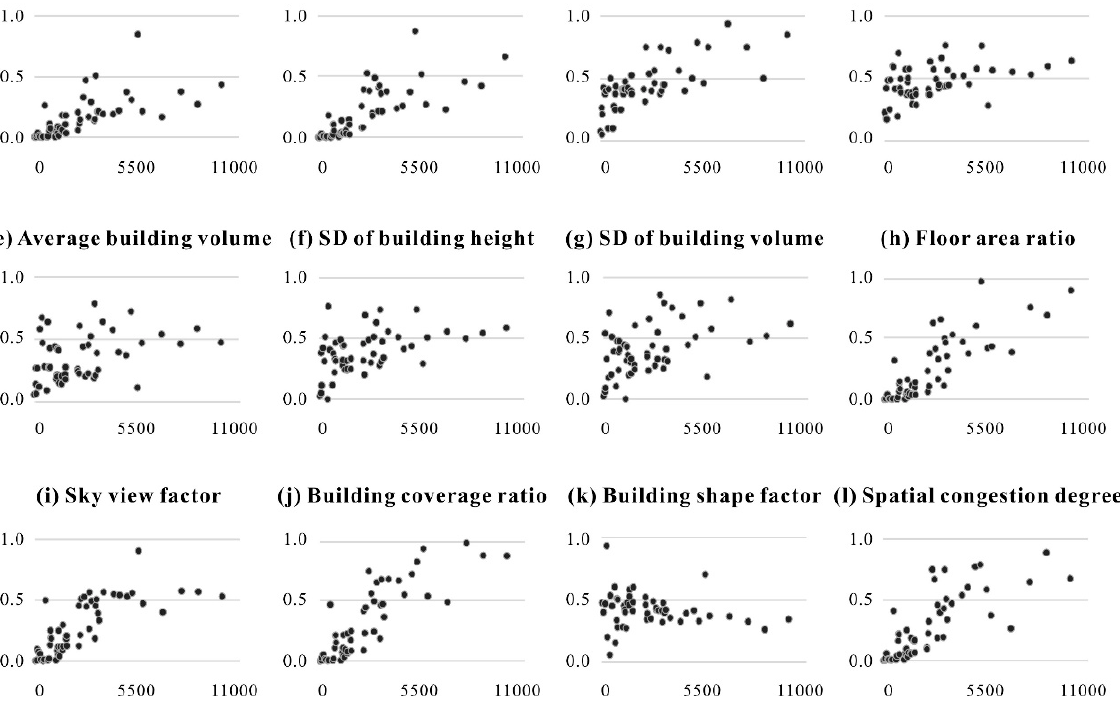
Figure 5. Scatter charts between urban vitality and each building-related indicator (the horizontal axis reflects the daily average accumulated population density at the township level, unit: people/km 2 ; the vertical axis reflects the normalized score for each indicator).